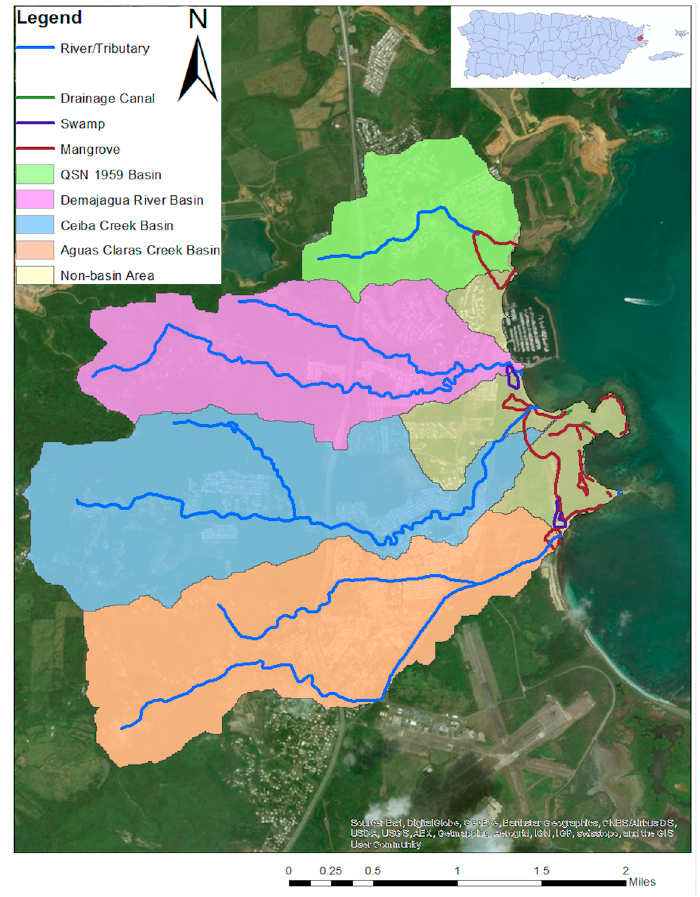
Figure 4. Hydrography of the watershed system within the area of interest. The delineation of each watershed and their river system is presented. A satellite image of the area of interest is also shown. The river/tributary path, the drainage channel location and the swamp and mangrove areas are delimitated on the figure. The Non-Basin Areas represents zones that does not have a river/tributary path; therefore, a watershed system cannot be defined [19].